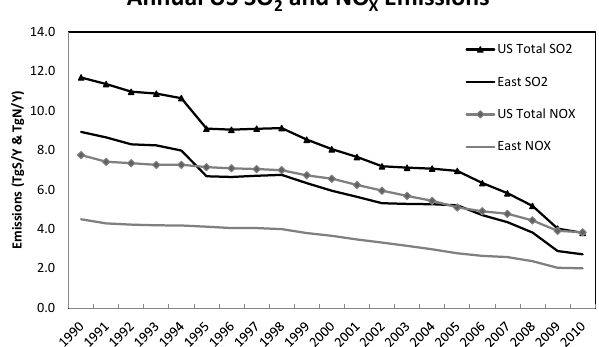
Figure 1. Annual US SO 2 (TgS) and NO x (TgN) emissions esti- mates between 1990 and 2010 (Xing et al., 2013).